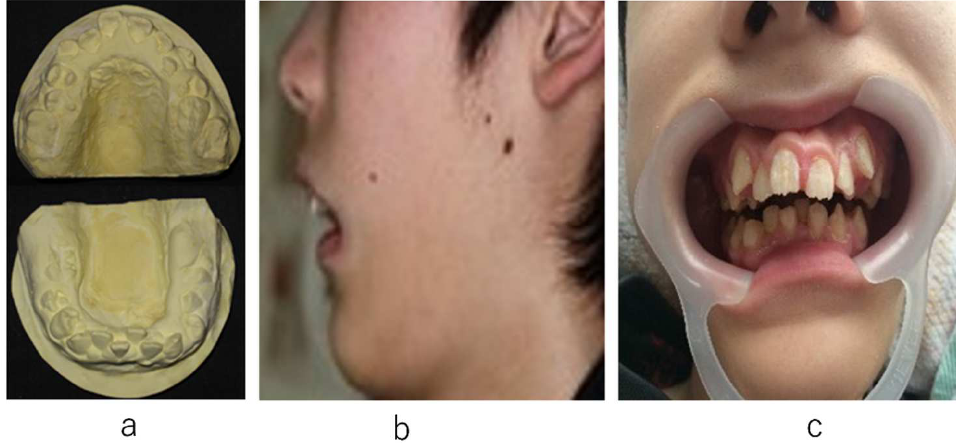
Figure 1. Initiation of orthodontic treatment. ( a ): Study model. ( b ): Facial profile. ( c ): Frontal view of the dental arch at the first visit.